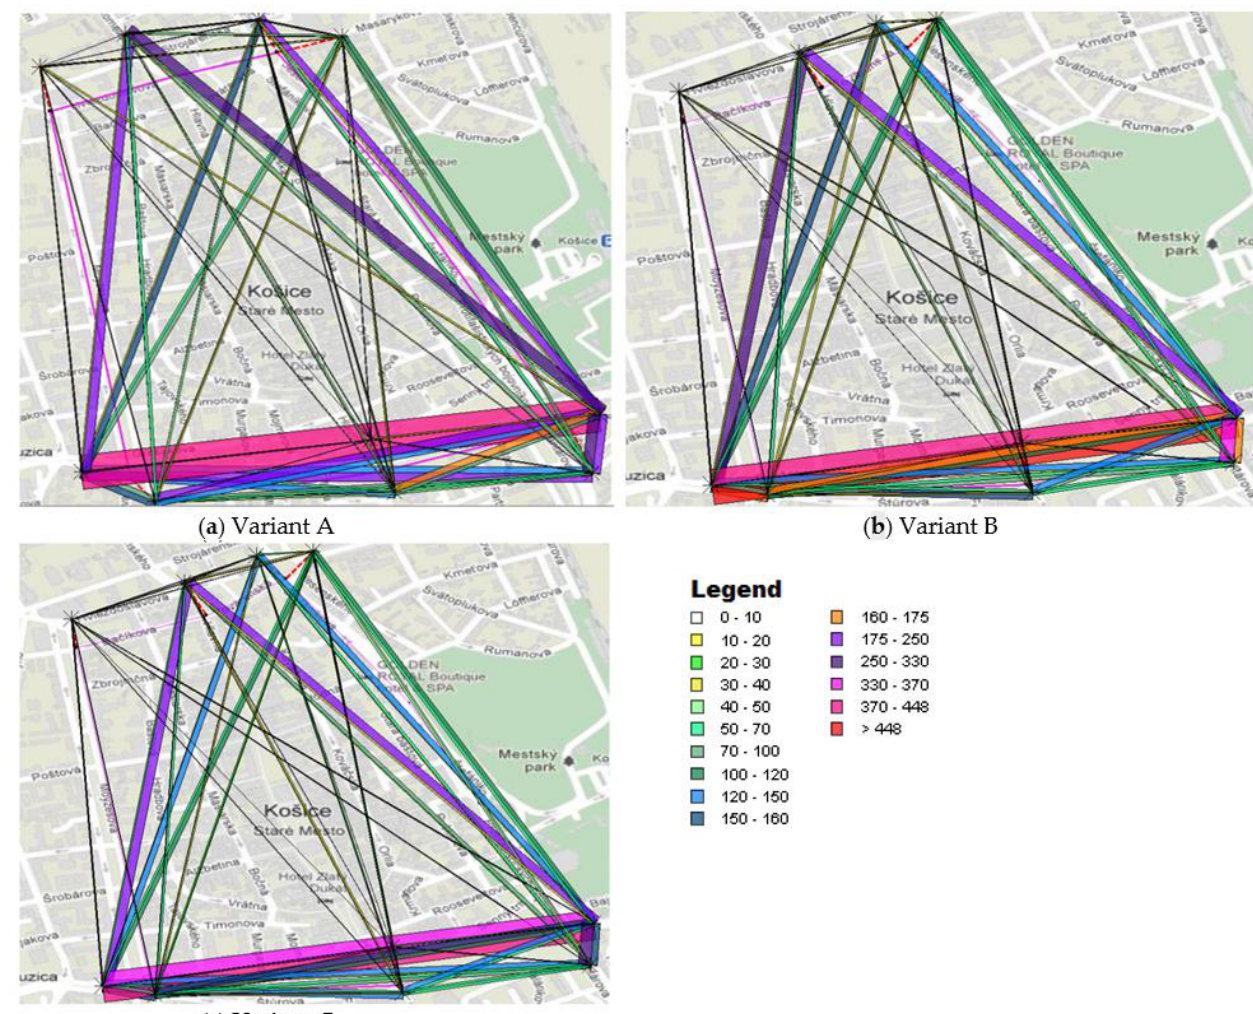
Figure 9. Illustration of inter-district relationships for Variant A ( a ), Variant B ( b ) and Variant C ( c ) (source elaborated by authors).